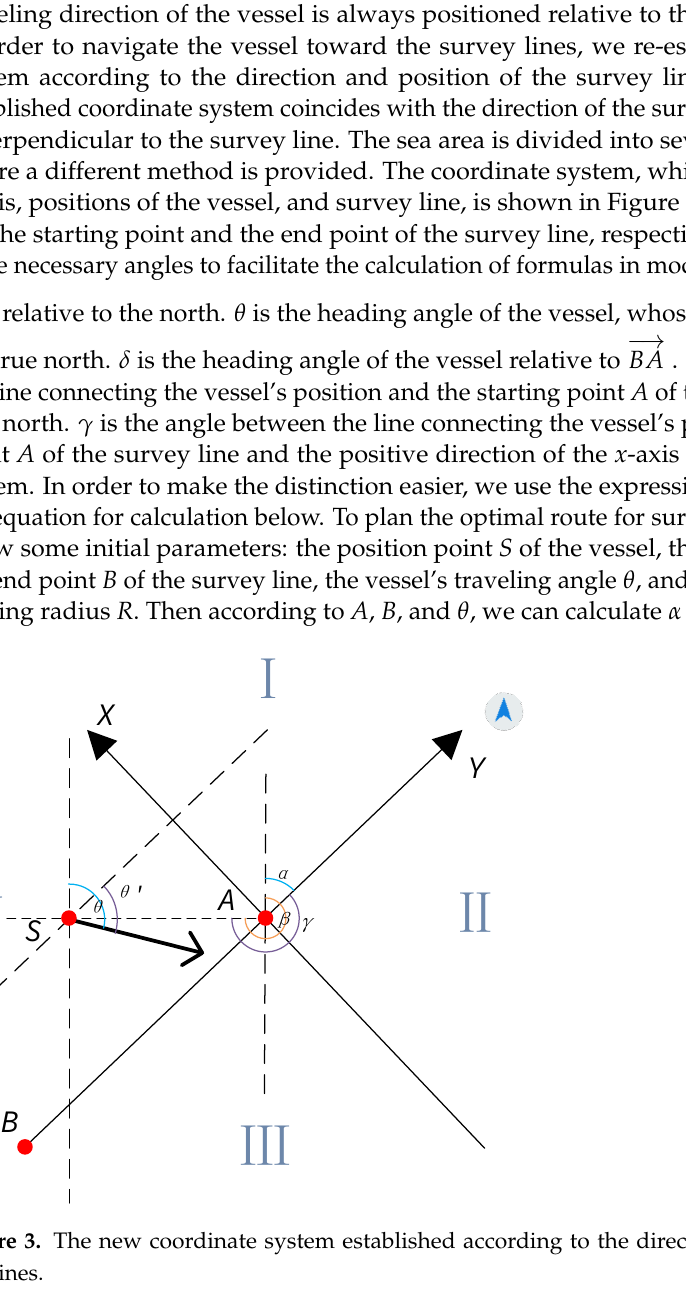
Figure 2. Survey line navigation methodological framework.